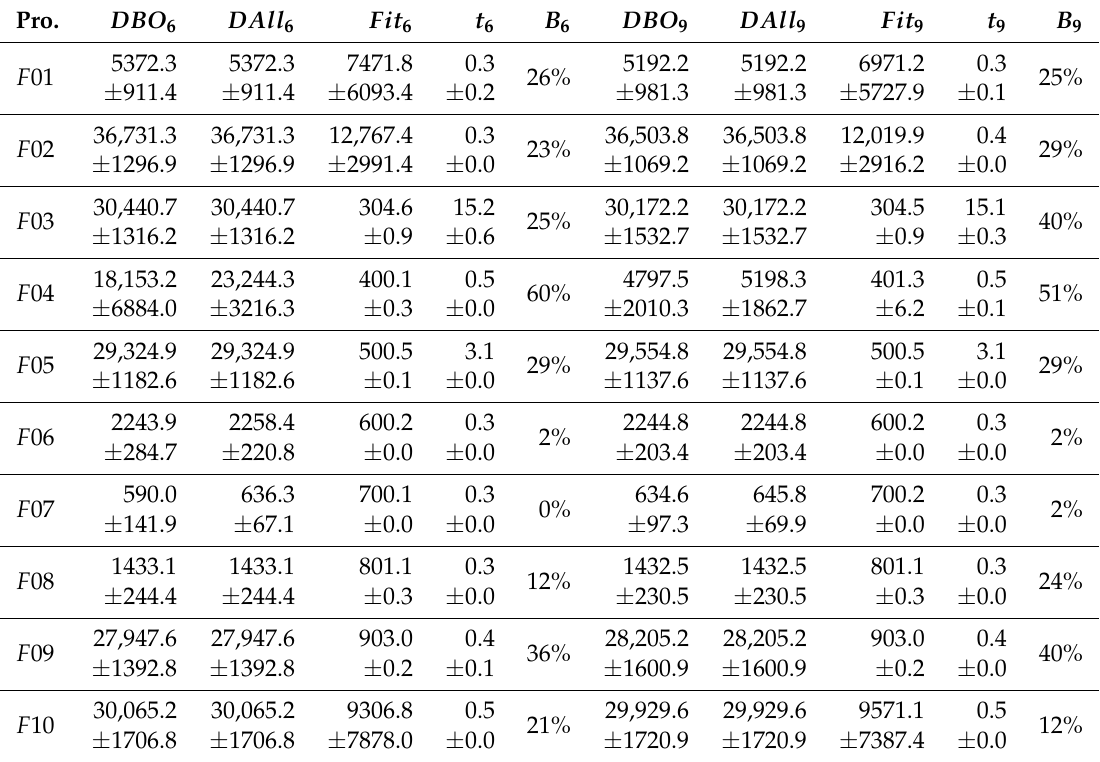
Table 9. ABC algorithm on CEC-2015 with LTMA e